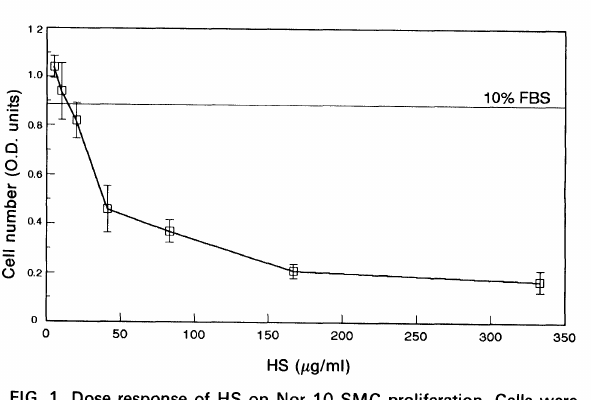
FIG. 1. Dose response of HS on Nor-10 SMC proliferation. Cells were treated with varying concentrations of HS as described in Materials and methods. O.D. was calculated as a mean of triplicate determinations _-+S.D. 10% FBS line represents level of Nor-10 growth in the absence of GAG